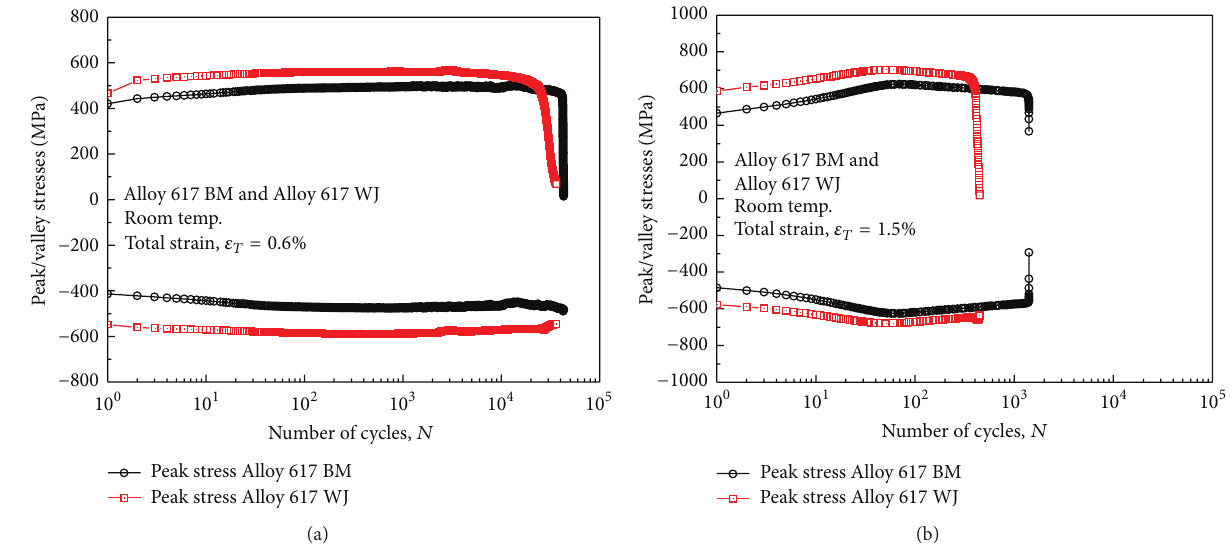
Figure 4: Peak/valley stresses versus number of cycles in LCF with total strain controlled of (a) 0.6% and (b) 1.5%.